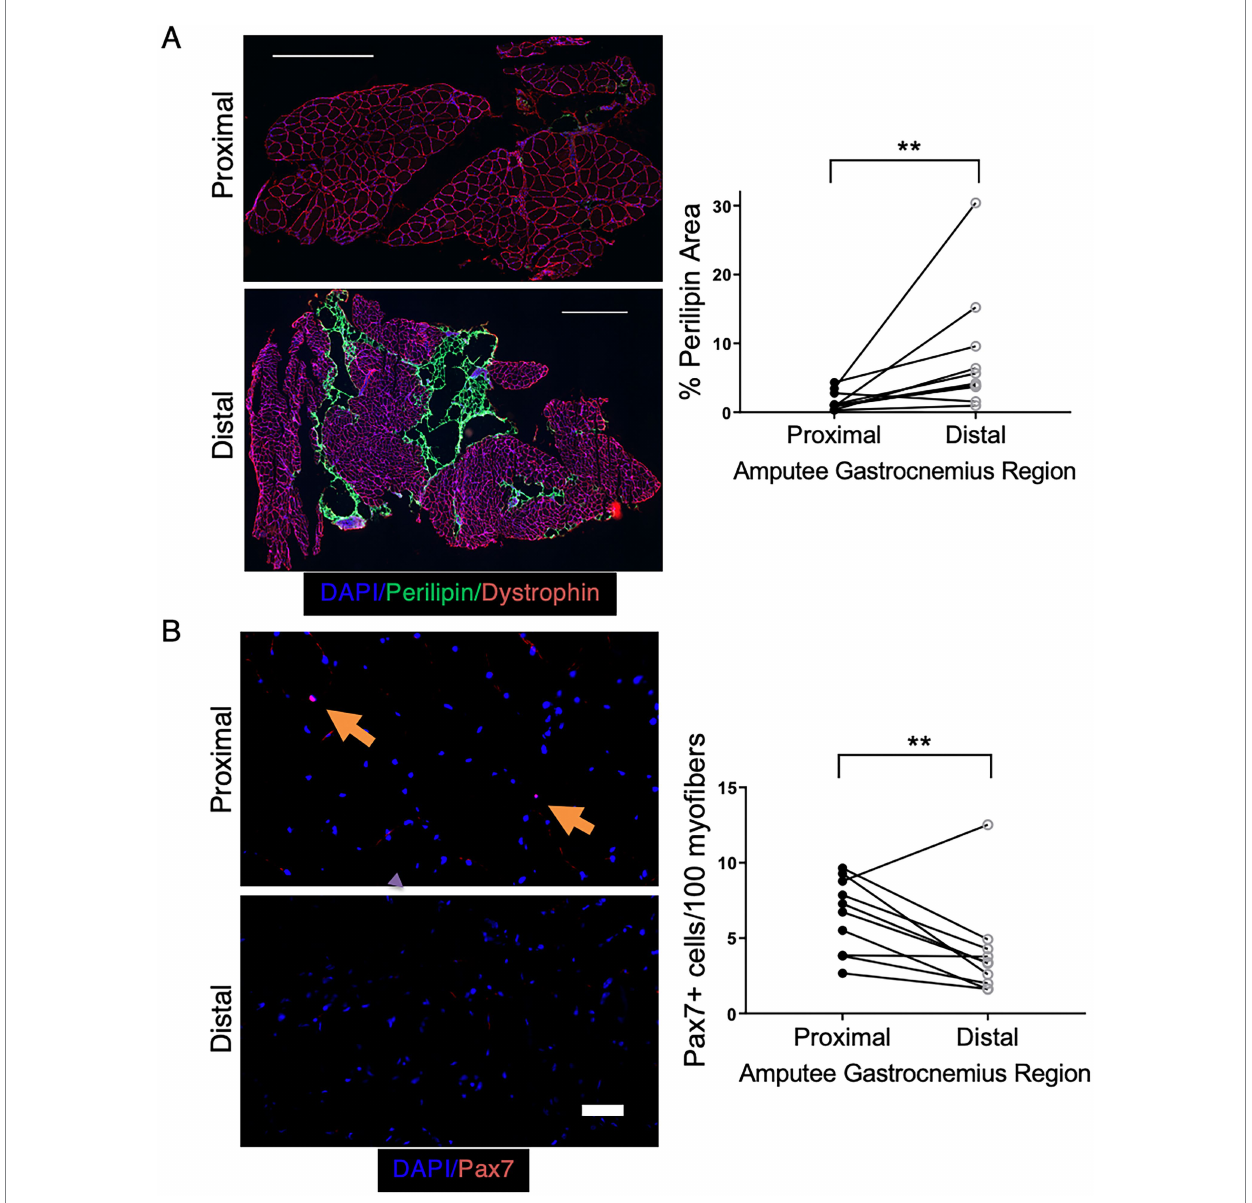
FIGURE 9 CLTI patients have increased adipogenesis in more ischemic muscle regions that correspond with decreased Pax7 + cell numbers. (A) Perilipin staining in the gastrocnemius muscle of CLTI patients ( n = 10) revealed significantly greater fat deposition in more distal ischemic regions. Scale bar = 1 mm (B) More ischemic distal regions of the same patients in panel (A) had significantly fewer Pax7 + cells. Scale bar = 100 μ m. All data shown are paired values from the same patient. ** p < 0.01 by a 2-sided ratio paired t